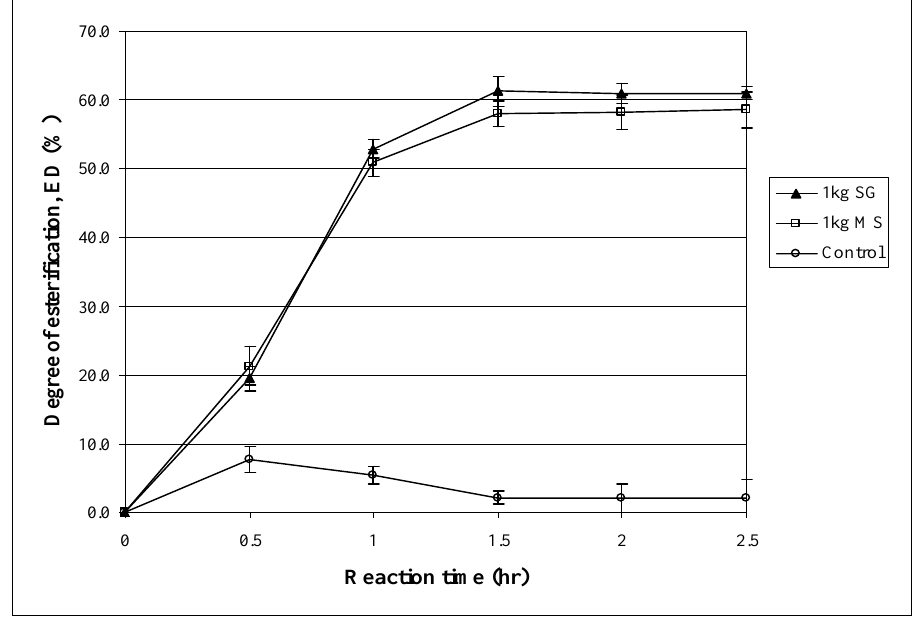
FIGURE 5. The effect of water-removal agents on the performance of intensified esterification in a PBR at 65ºC. The reaction mixture consisted of 2.0 kg PFAD, 0.336 kg glycerol (at molar ratio of 2.0), and 4.0 kg hexane. The water-removal column was filled with 1 kg silica gel (SG) or same amount of molecular sieve (MS). For the control experiment, the water-removal column was left empty. The PBR was filled with 10 kg of immobilized RBL. Samples were tested in